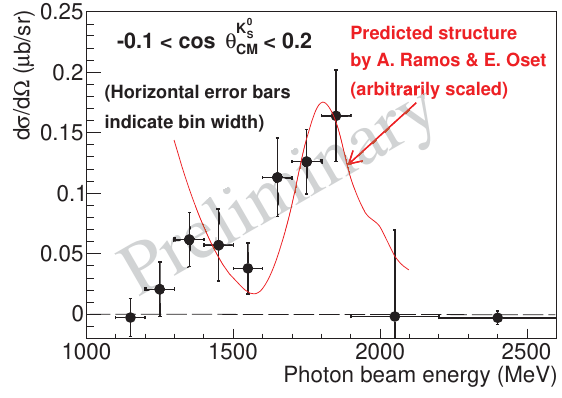
Σ 0 di ff erential cross section. Figure 9. Preliminary γ p → K 0 S The arbitrarily scaled peaked structure predicted by Ramos and Oset [29] is overlayed (see text for details). Analysis by K. Kohl [30]. Figure 11. Missing mass from K + π 0 system versus K + missing mass. Yellow labels indicate hyperon mass peaks and red arrows indicated expected missing mass from the K + π 0